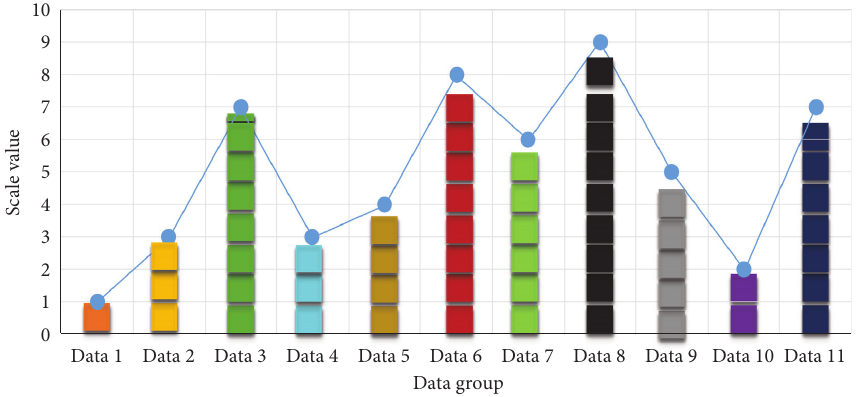
Figure 4: Simulation results of the wind instrument feature extraction model.